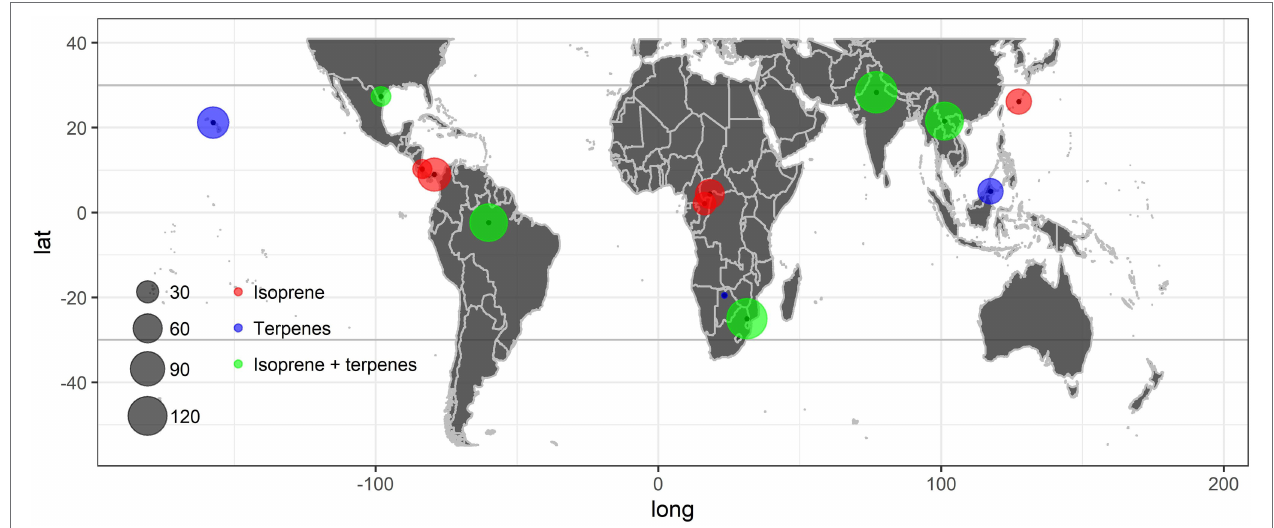
FIGURE 1 | Distribution of the tropical plant species with isoprenoid emissions reviewed in this study ( Appendix S1 ). Red represents areas where isoprene is the only isoprenoid reported, blue represents areas where terpenes are the only isoprenoids reported, green represents areas where isoprene, terpenes, or both isoprene and terpenes are the isoprenoids reported. The size of the circle is proportional to the number of tropical species